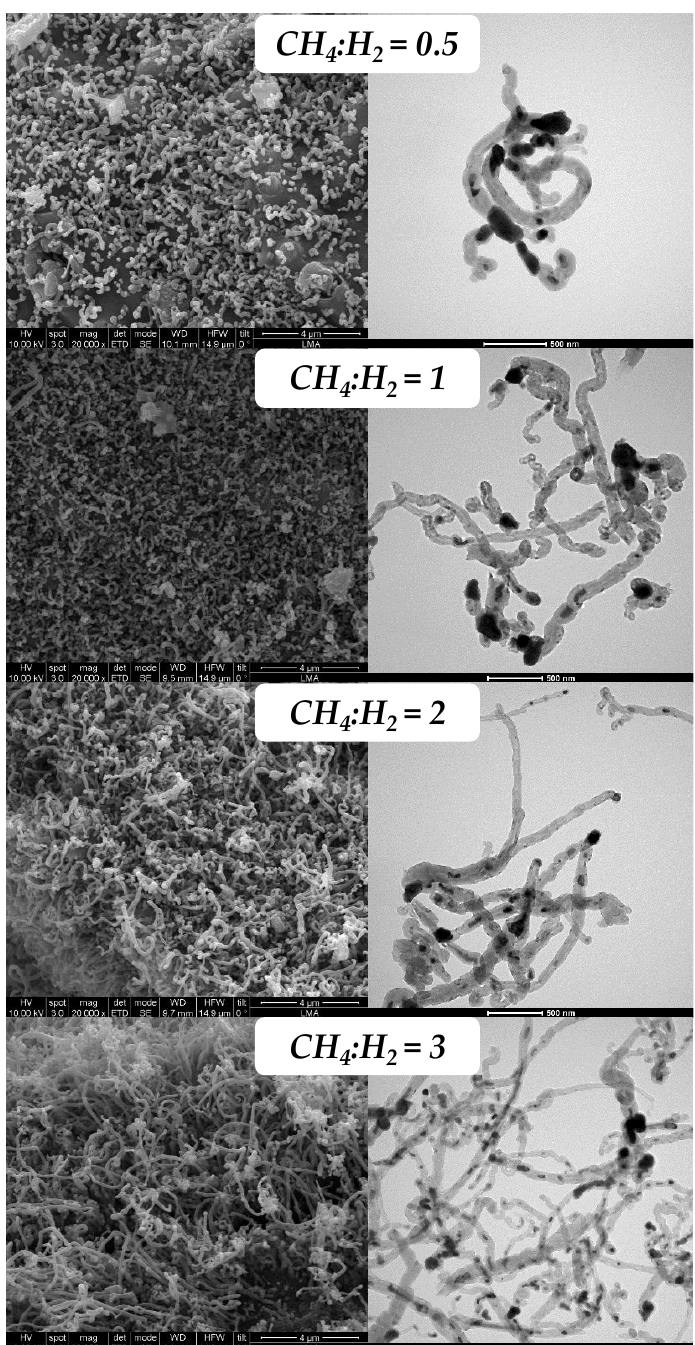
Figure 9. SEM and TEM images of the carbonaceous nanomaterials grown at different CH 4 :H 2 ratios for Ni – Cu/ArDC. Reaction temperature: 800 °C.